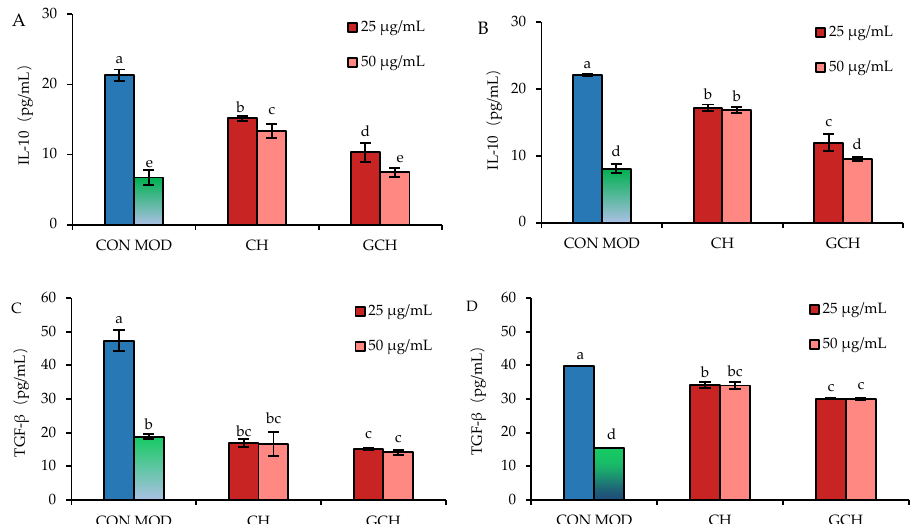
Figure 5. Secretion of IL-10 ( A , B ) and TGF- β ( C , D ) in IEC-6 cells treated with casein hydrolysate (CH) and glycated casein hydrolysate (GCH) for 12 h ( A , C ) and 24 h ( B , D ), respectively, followed by 10 μg/mL LPS treatment of 24 h. The abbreviation “CON” and “MOD” denotes the control and model cells, respectively. The one-way ANOVA of the mean values with different lowercase letters above the columns indicates a significant difference ( p < 0.05).